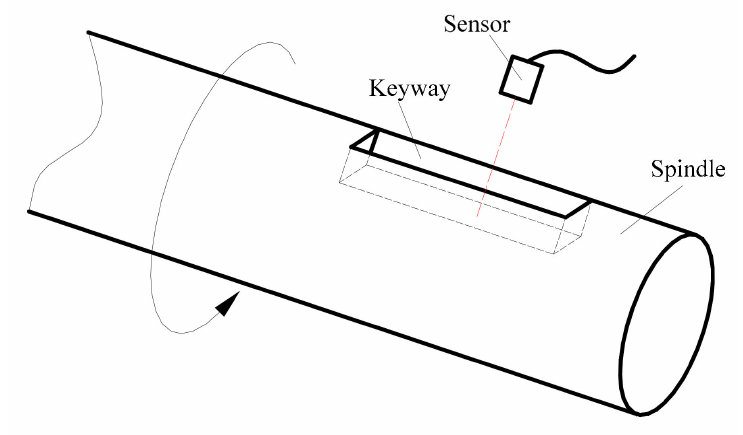
Figure 11. Key phase signal